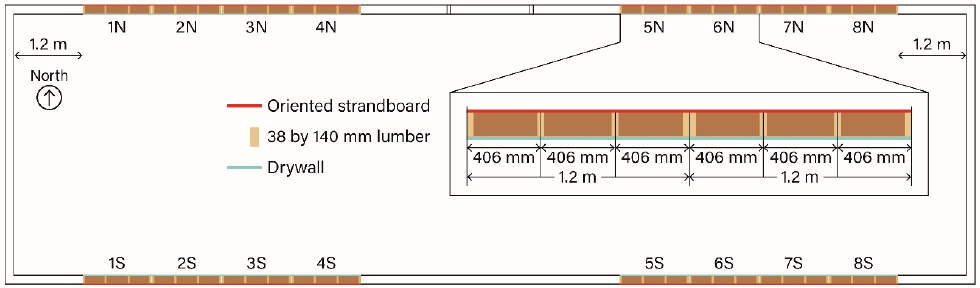
Figure 1. Test structure for field measurements with 8 different wall assemblies. Table 1. Wall configuration summary.